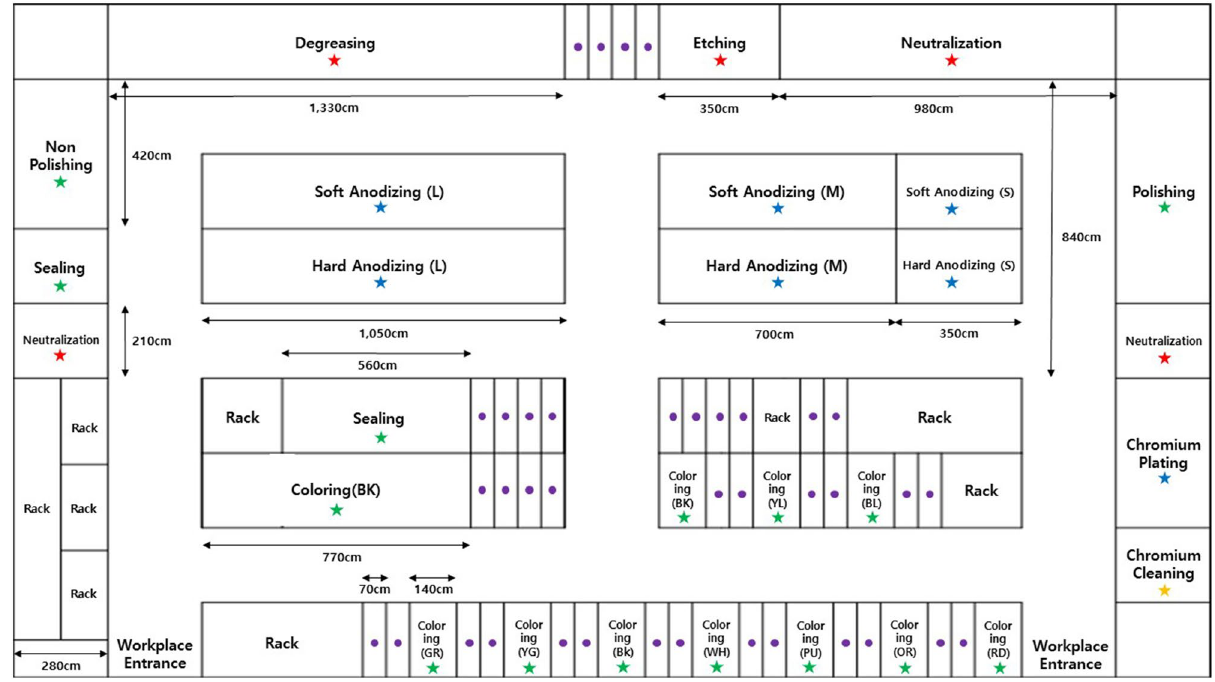
Figure 1. Anodizing and Electroplating schematic and sample location 1: the icons are the sampling locations (red star: pre-treatment process, blue star: anodizing and electroplating process, green star: post-treatment process, orange star: other processes, purple circle: cleaning process). RD Red, OR Orange, YL Yellow, GR Green, BL Blue, PU Purple, YG Yellow Green, WH White. Workplace (35 m × 17.85